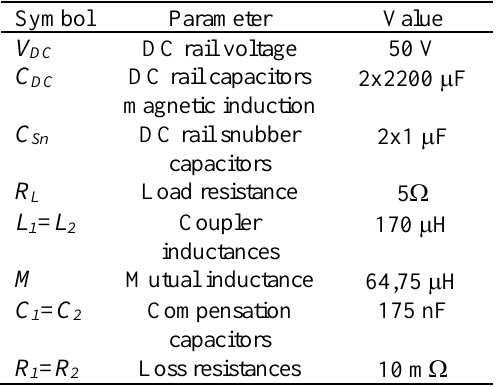
corresponding input current are shown with maize and cyan colored lines, respectively.